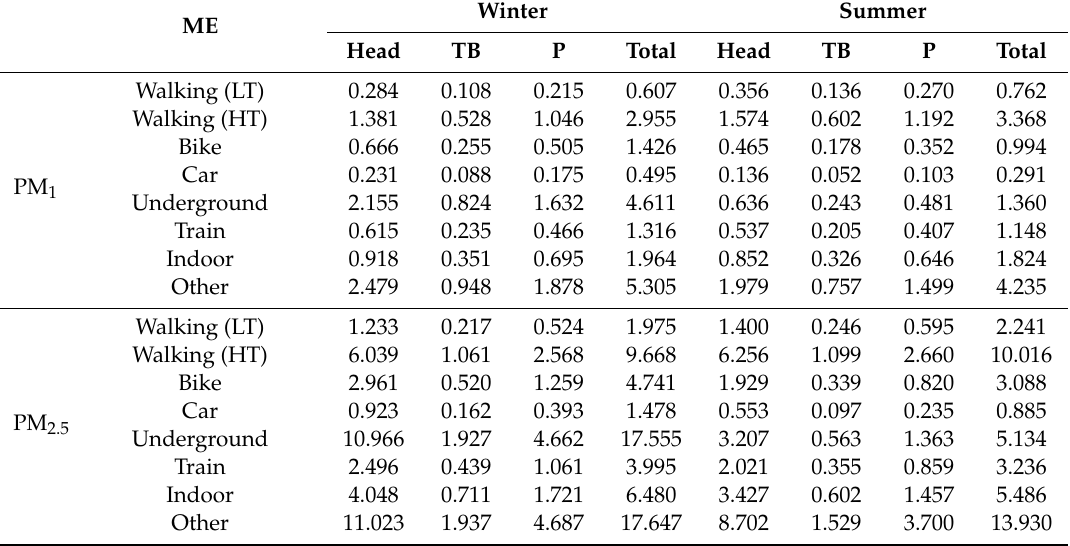
Figure 2. PM deposited mass ( µ g) in the respiratory tract (H: head; TB: tracheobronchial; P: pulmonary; total: H + TB + P). Black: PM 1 ; Blue: PM 2.5 ; Green: PM 4 ; Yellow: PM 10 . Table 3. PM deposited mass ( µ g) in the respiratory tract (H: head; TB: tracheobronchial; P: pulmonary; total: H + TB + P) estimated across the micro-environments (MEs) visited by the